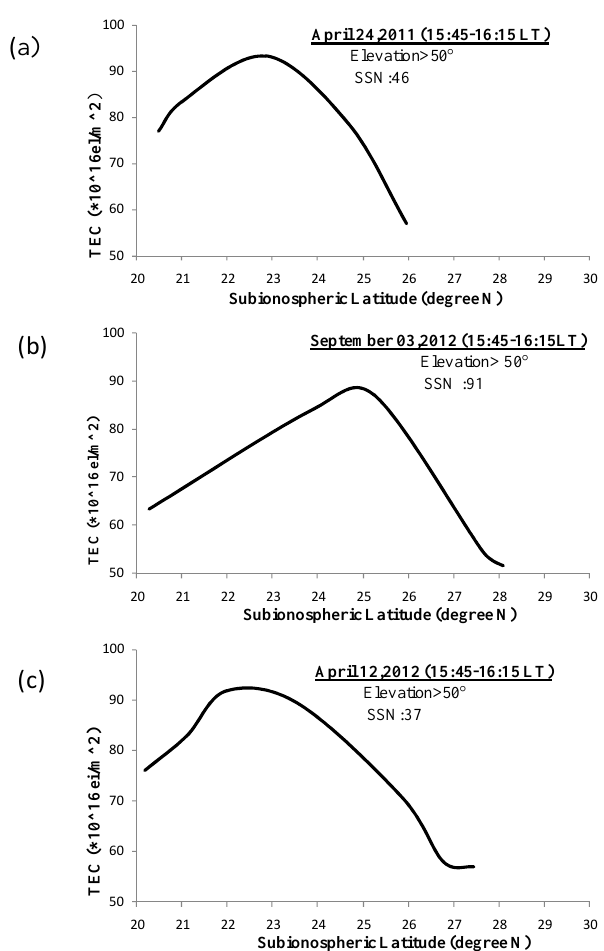
Figure 2 Fig. 2. (a–c) Latitudinal gradient of VTEC, existing away from the magnetic equator to the northern crest of EIA and beyond, measured at three stations with elevation angles greater than 50 ◦ at different subionospheric latitudes ranging from 20 ◦ N to 30 ◦ N on 3 days, namely, 24 April 2011, 3 September 2011 and 12 April 2012.